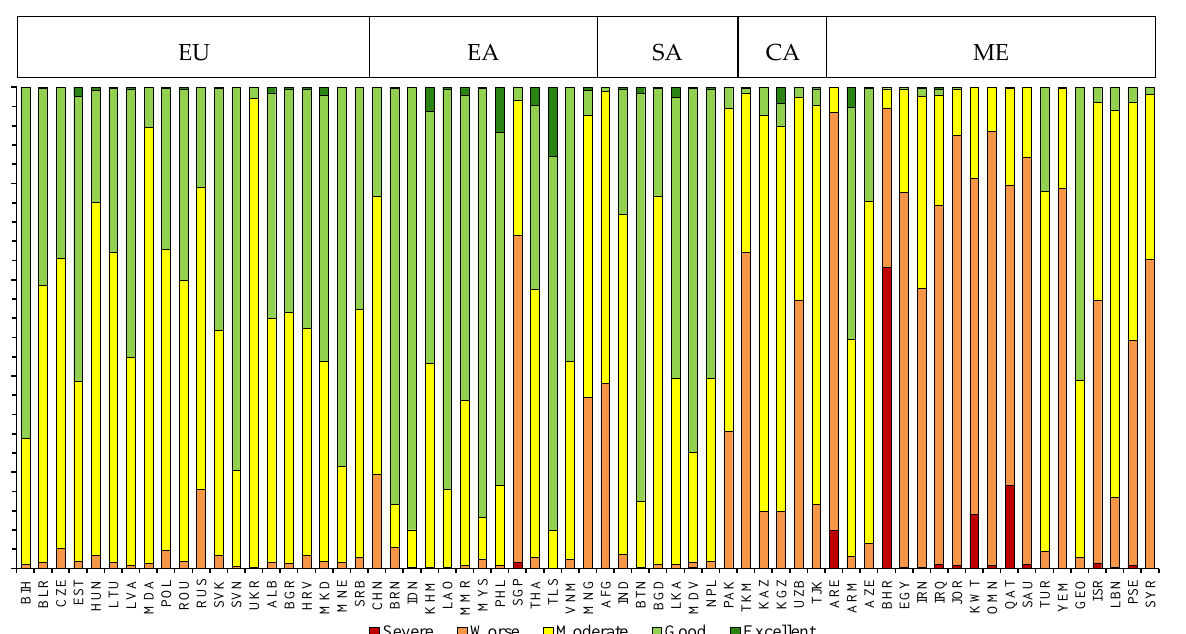
( b ) Figure 2. Spatial distribution of ecological quality levels in the Pan-Third Pole region ( a ) in 2000; ( b )